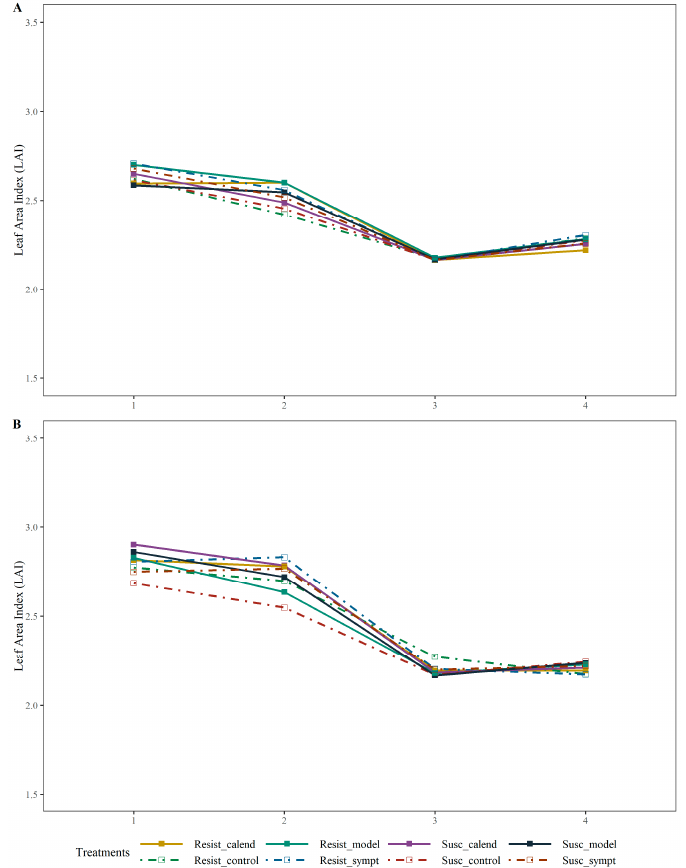
Figure 15. Defoliation assessment based on the leaf area index (LAI) through the integration of NDVI and Beer–Lambert law, according to the spectral curves of the susceptible and partially resistant soybean cultivars under soybean rust effect, across experimental evaluation periods of Field 1 ( A ) and Field 2 ( B ). Notes: Susc_: susceptible soybean cultivar (DS6217); Resist_: partially